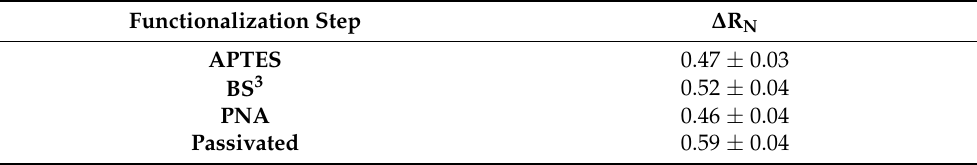
Figure 4. PL spectra ( A ) and I–V curves ( B ) of ZnONW-based device after each functionalization step. Table 2. Calculated R N values after each functionalization step.